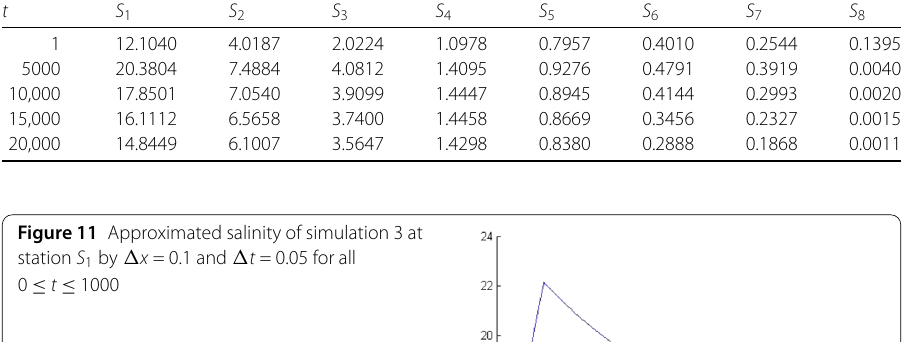
Table 9 Approximated salinity c ( x , t ) of simulation 3 for all monitoring stations